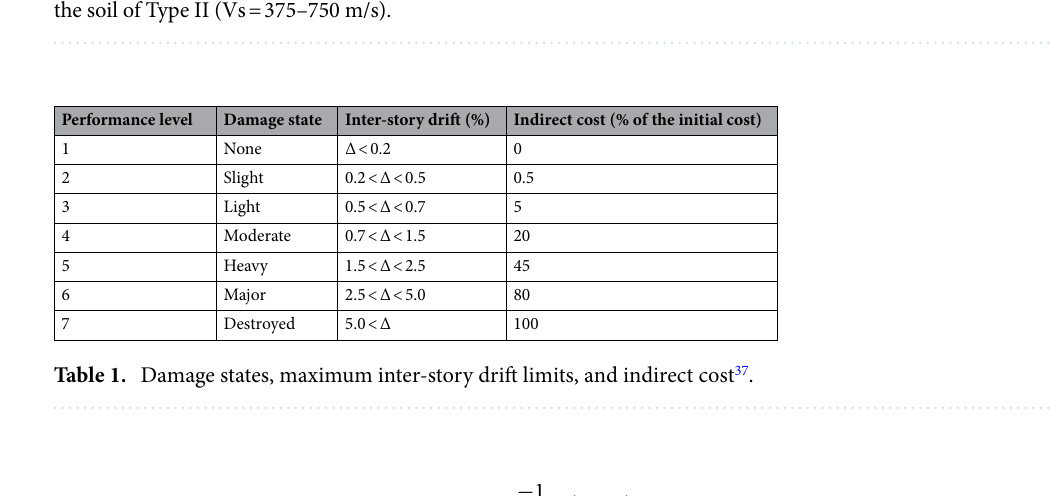
Figure 3. Spectrum accelerations of 2%, 10%, and 50% probability of exceedance over 50 years for Tehran with the soil of Type II (Vs = 375–750 m/s).